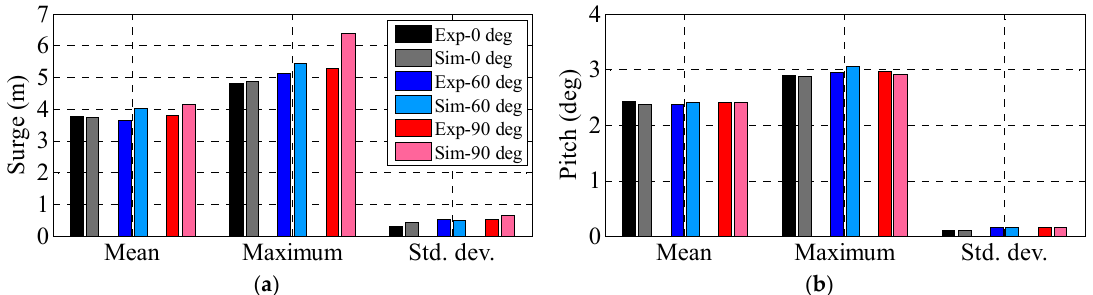
Figure 23. Statistical comparisons of the FAST simulation and model test data between three aligned wind/wave directions: ( a ) Surge response; ( b ) Pitch response.